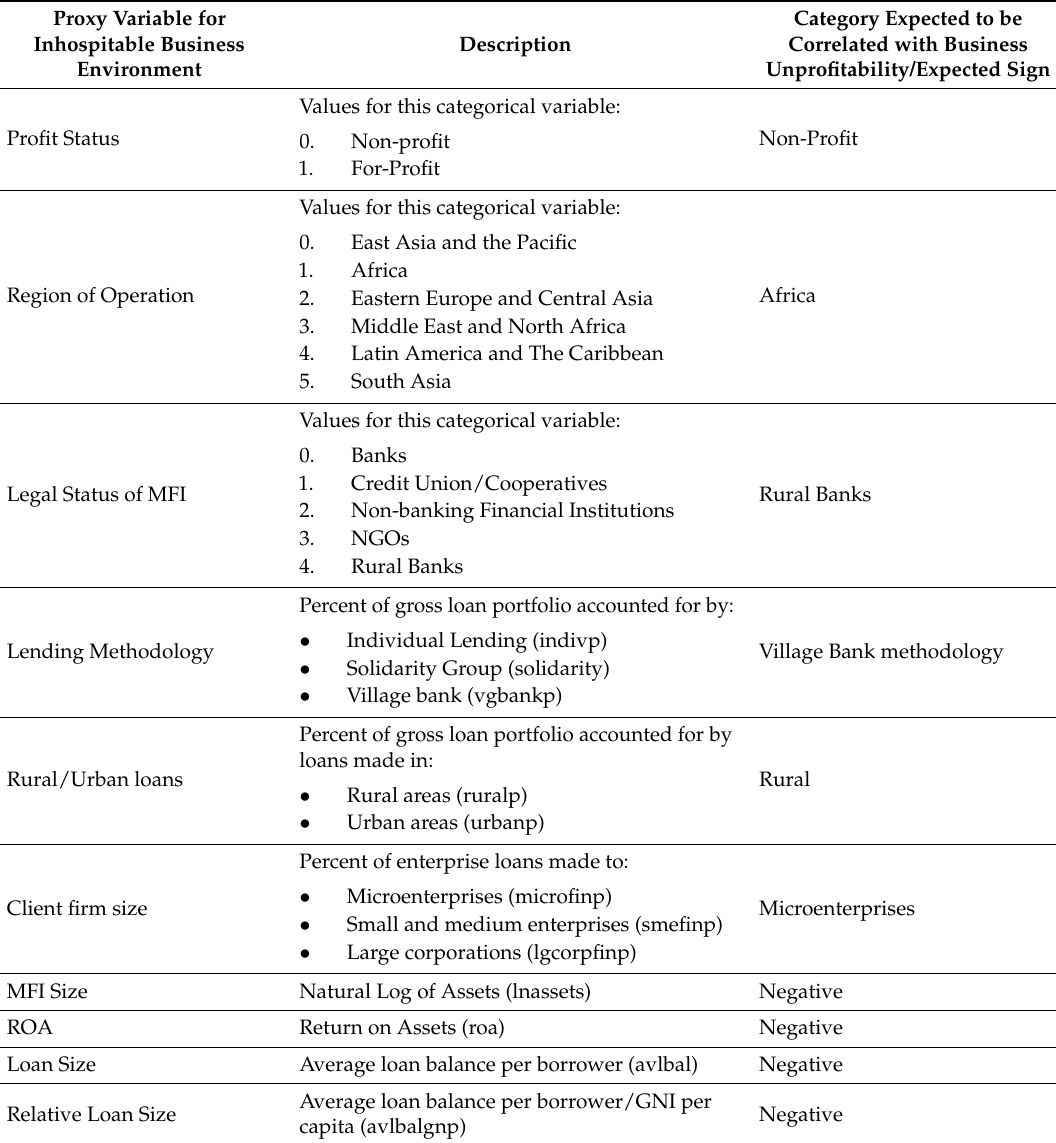
Table 1. List of proxy variables for an inhospitable business